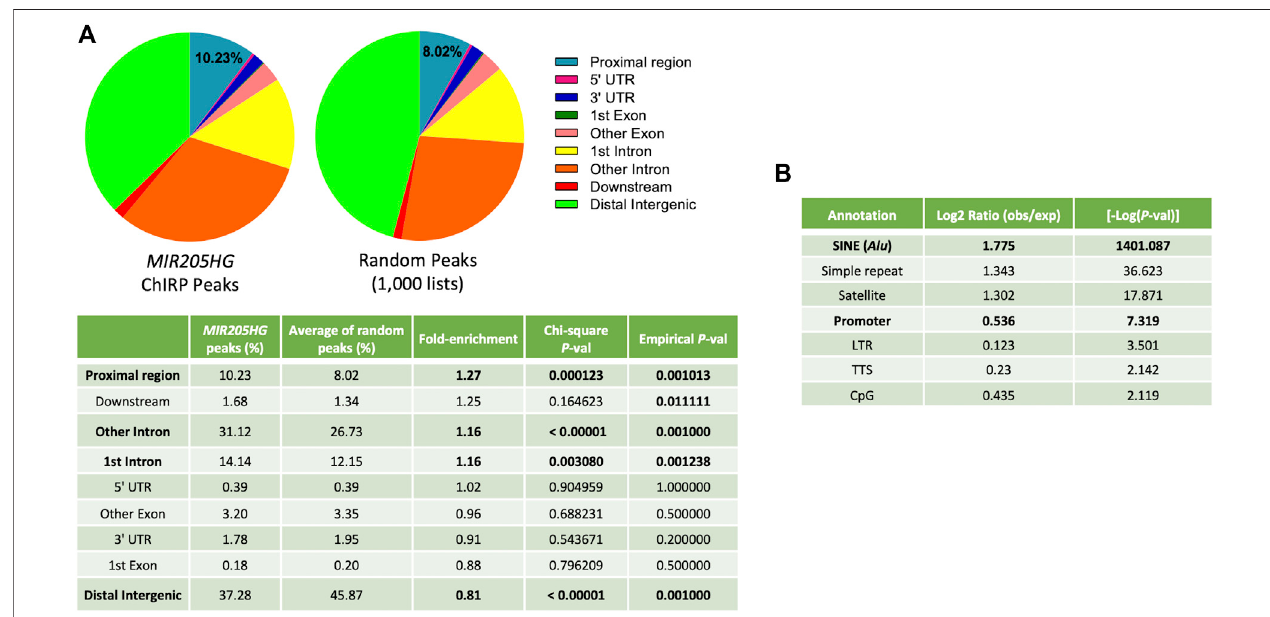
FIGURE 1 | Genome distribution of MIR205HG ChIRP consensus peaks as compared to random regions. (A) Feature enrichment analysis performed using the annotatePeak function of ChipSeeker R package on 5,064 consensus peaks and on 1,000 lists of about 5,000 random peaks of equal nucleotide length. The pie plots were generated using GraphPad prism. Chi-square test p -values calculated againstthe average percentage ofeach featurein random gene lists and empirical p -values associated with permutation analyses are reported in the enclosed table. Proximal Region = − 1,500 to +500 bp from gene TSS; Downstream = within 3,000 bp fromgenetermination. (B) Featureenrichmentanalysisperformedusingthe annotatePeaks.pl functionofHOMERsoftwareon5,064consensuspeaks.Thetableswere generated using Microsoft Excel.